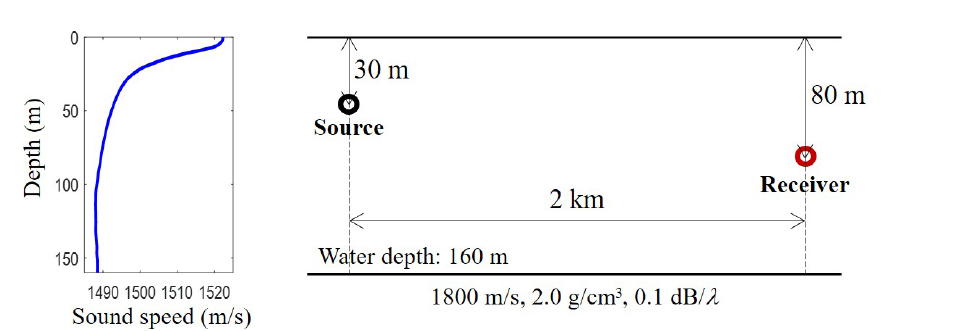
Figure 2. Numerical experiment environment: The sound speed profile is calculated as the mean of 26 CTD (Conductivity, Temperature, Depth) casts from SwellEx-96. The horizontal range between source and receiver is 2 km and their depths are 30 m and 80 m, respectively. The water depth is 160 m. Sound speed, density, and attenuation are 1800 m/s, 2.0 g/cm 3 , and 0.1 dB/ λ , respectively.